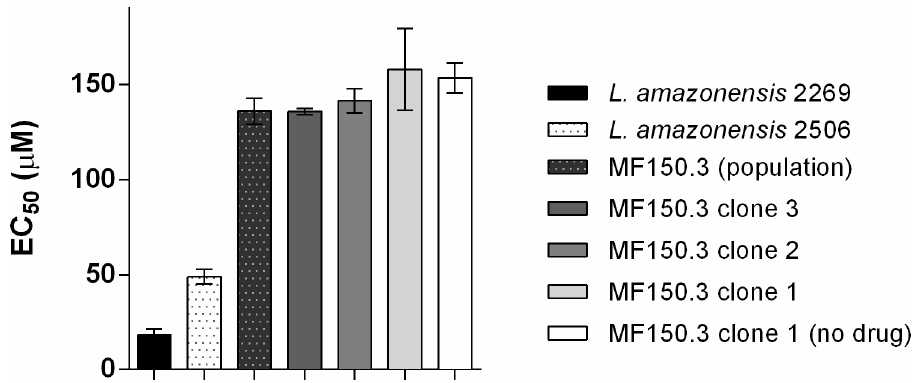
Figure 1. Activity of MF against promastigotes of L.amazonensis . MF susceptibility in promastigotes of L. amazonensis mutants and wild-type parasites. EC 50 values for MF against M2269 strain, 2506 isolate and MF150.3-1 mutants were determined by MTT as described in Material and Methods. The average and standard deviation of three independent experiments in triplicate is